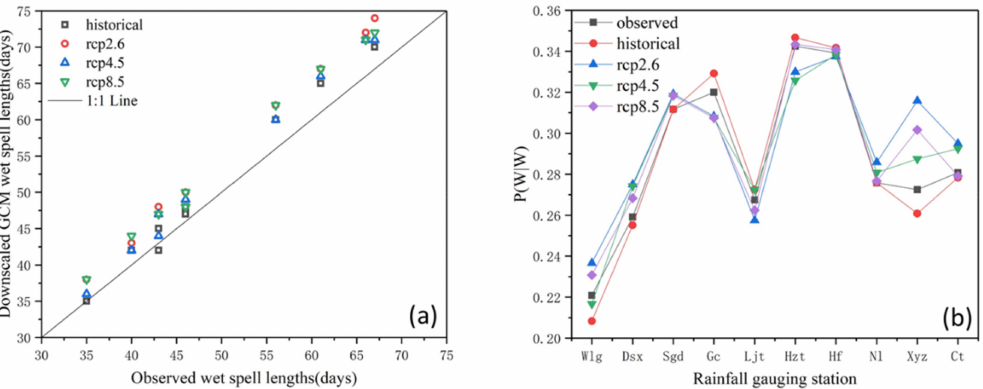
Figure 6. Comparison, in terms of wet spell lengths and the probability of a wet day following a wet day ( P(W | W) ), between statistical values of the observed data and the CLIGEN-generated data without shu ffl ing (pre-shu ffl ed data) in the Huangfuchuan Basin. The historical period is 1976–2005. The projection period is 2021–2070. ( a ) wet spell lengths; ( b ) P(W | W) , the probability of a wet day following a wet